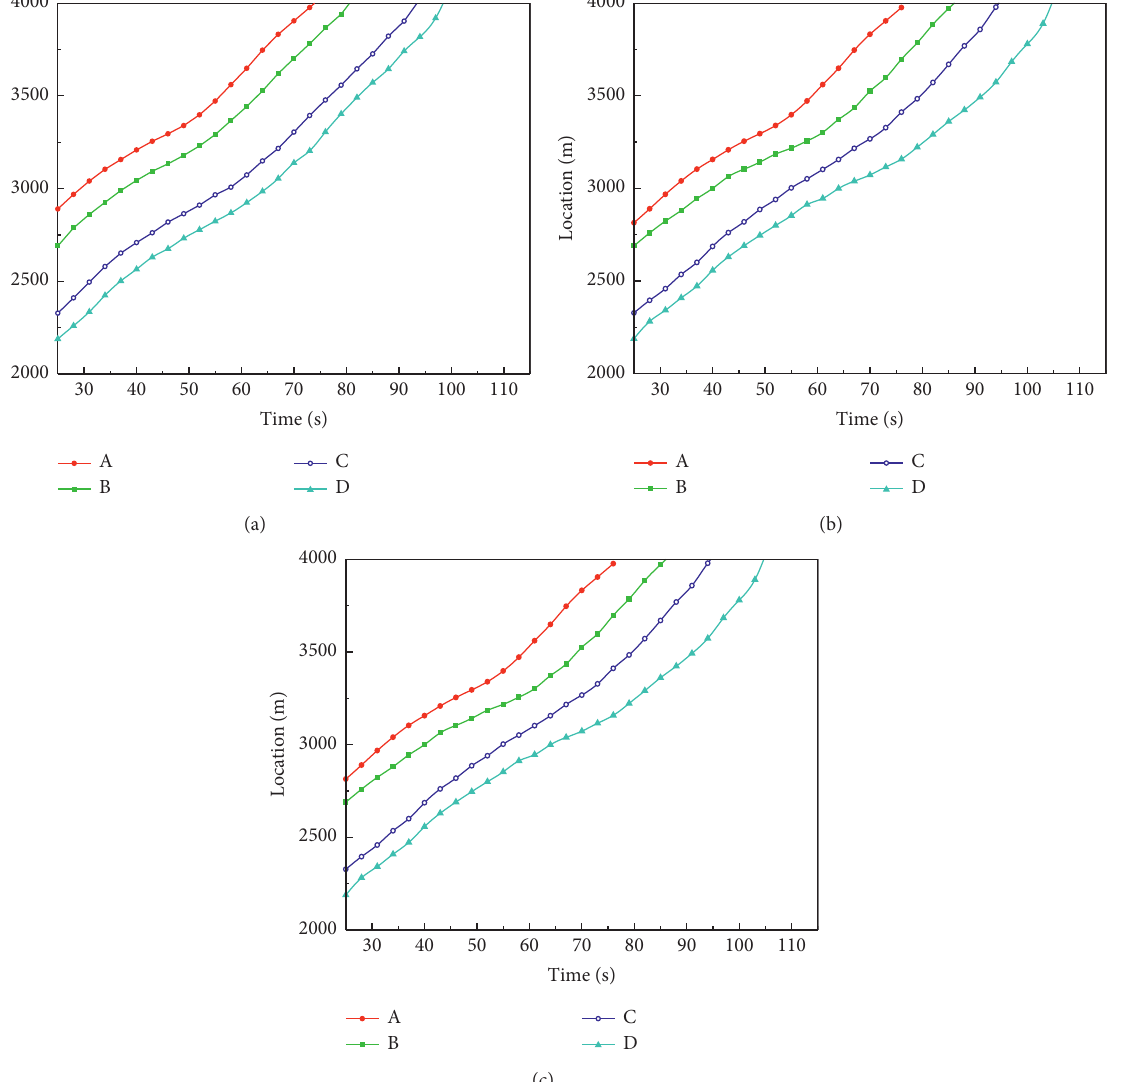
Figure 10: Comparison of spatiotemporal trajectories. (a) OV following model. (b) Molecular following model. (c) Measured